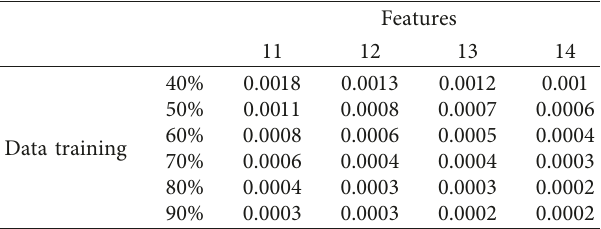
Table 3: PSO-SVR NMSE values of Alam Sutera Reality Tbk (ASRI).